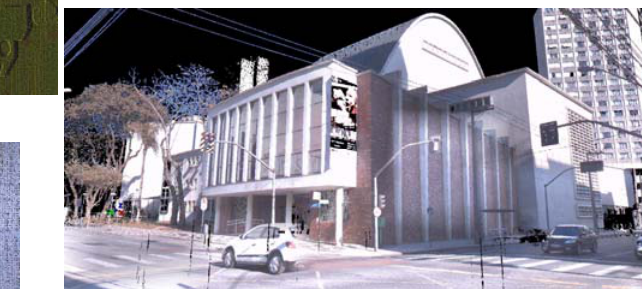
Figure 11. Image Texture Map on Point Clouds: structural faults and tiny cracks on walls were not visible